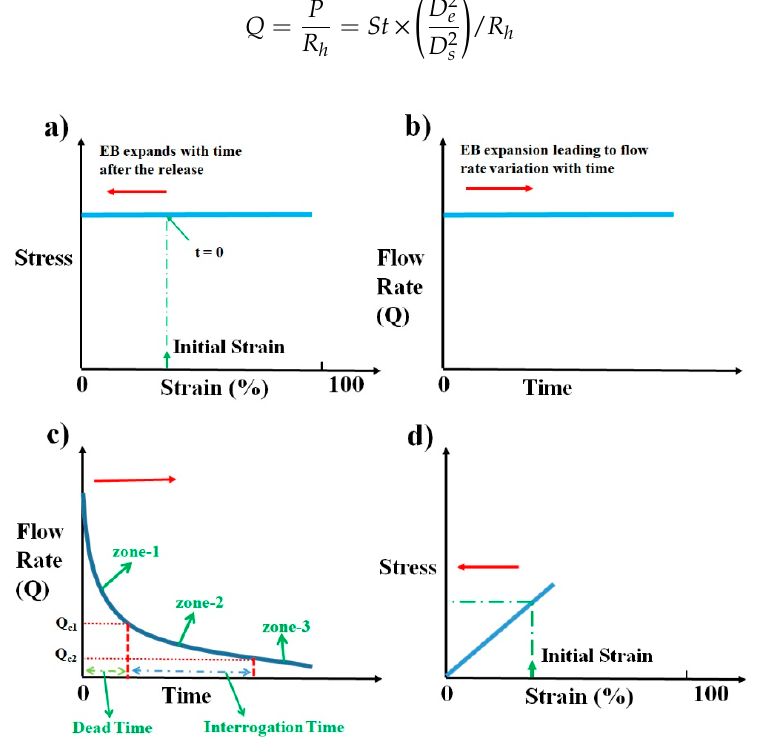
Figure 3. Schematics illustrating the flow rate variation with time and the respective stress–strain behavior desired from an elastomeric block. ( a ) Schematic of ideal stress–strain curve desired from an elastic material to produce a constant flow rate throughout the relaxation duration of the elastic block. ( b ) Schematic representing the expected flow rate variation with time. ( c ) Schematic illustrating the ideal flow rate characteristics desired for a pump that is suited to microfluidic point-of-care diagnostic (POCD) devices. ( d ) Schematic illustrating the proposed stress–strain curve to obtain the desired flow rate characteristics in (c). Arrow indicates the time evolution of strain during the operation of pump in (a,d), whereas it indicates the respective time evolution of flow rate with time in (b,c).